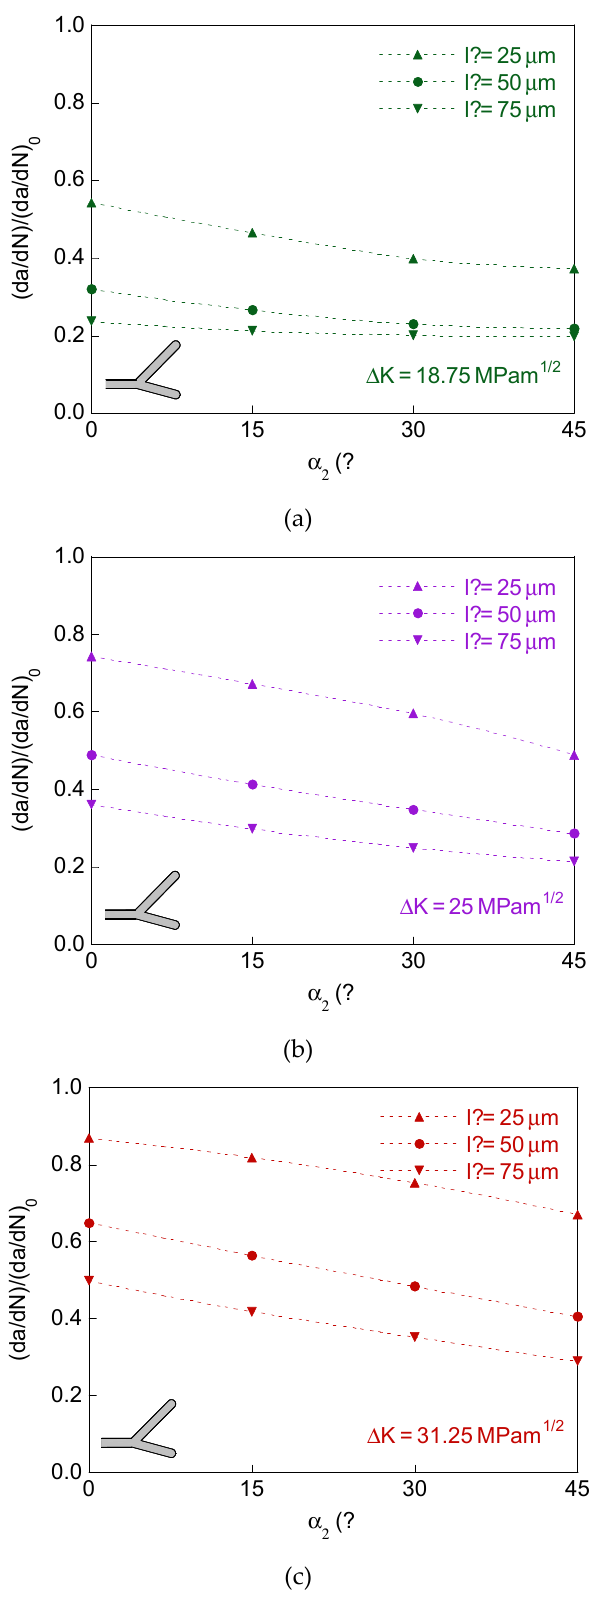
Figure 6. Retardation factor for bifurcated crack tip with equal initial projected length and different initial angle in the two branches: ( a ) Δ K = 18.75 MPam 1/2 ; ( b ) Δ K = 25 MPam 1/2 ; ( c ) Δ K = 31.25 MPam 1/2 .